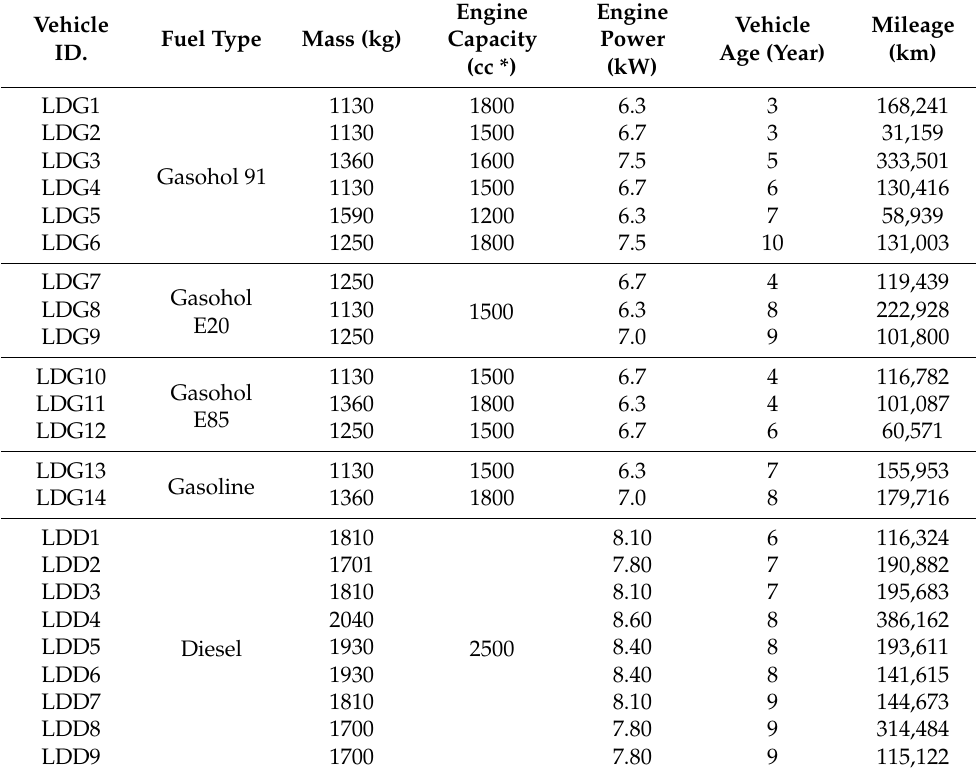
Table 1. The light-duty classification of vehicles tested by fuel types.